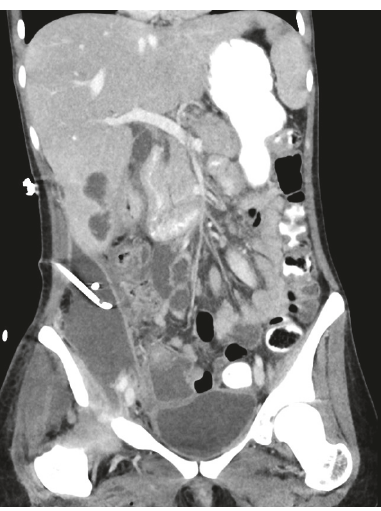
Figure 2: Computed tomography shows the retroperitoneal abscess after the insertion of the transcutaneous drainage.